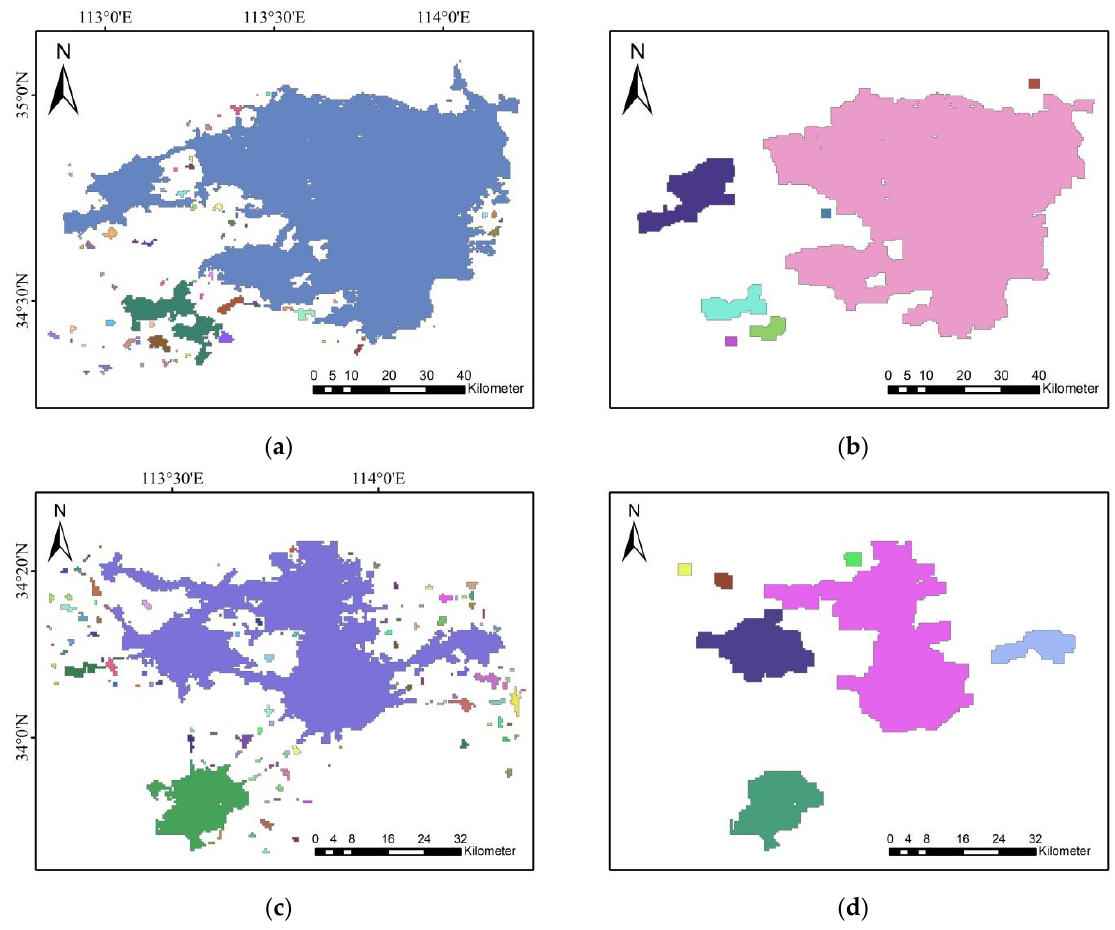
Figure 5. Contraction-based connectivity of Zhengzhou and Xuchang in 2020: ( a , c ) are the previously weakly connected regions, ( b , d ) are the regions after contraction-based connectivity analysis. The different colors in ( a ), ( b ), ( c ) and ( d ) represent different connected components.